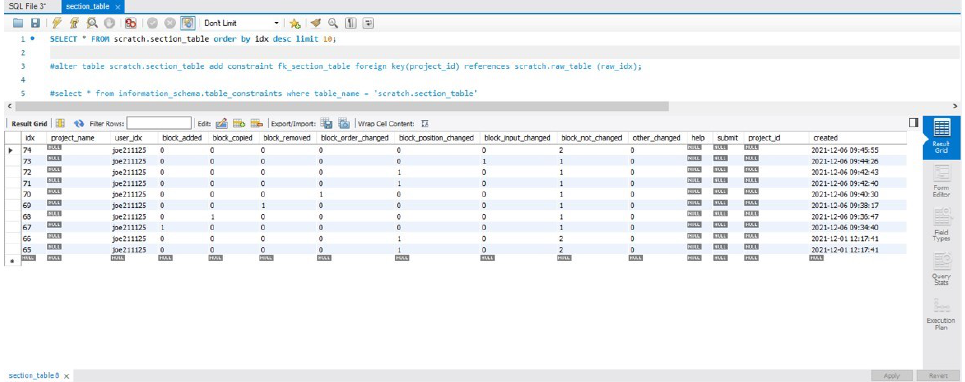
Figure 3. User log collection and database